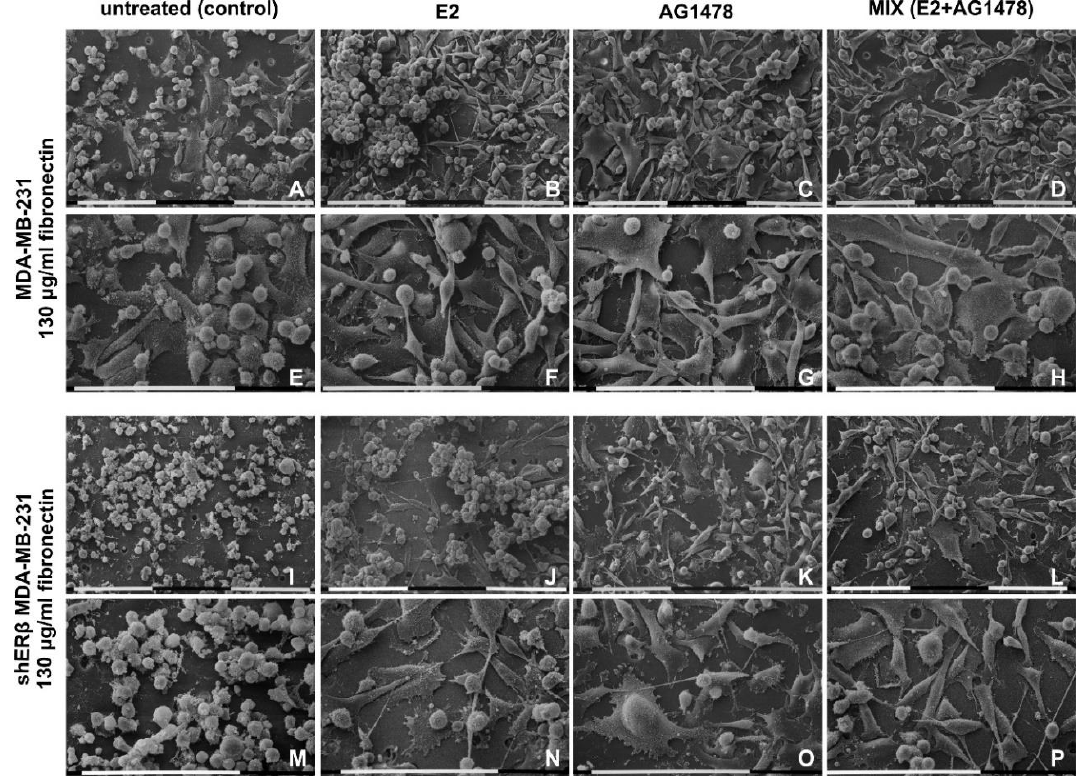
Figure 6. MDA-MB-231 and shERβ MDA-MB-231 cells cultured on Millipore filter covered by 130 µg/mL FN. ( A , E ) Untreated MDA-MB-231 cells displayed three different cell phenotypes: more numerous globular cells, large flattened-polygonal cells and fewer elongated-fusiform ones. Very few short filopodia and only few intercellular TNTs are observable. ( B , F ) With E2 treatment, MDA-MB-231 cells show isolated or grouped globular cells usually growing in more than one layer on more numerous elongated-fusiform and flattened-polygonal ones. Long conical filopodia and intercellular TNTs are visible. ( C , G ) After treatment with AG1478, MDA-MB-231 cells appear more grouped and include globular phenotypes growing on fewer elongated-fusiform and increased very large flattened-polygonal ones vs. control group. Few filopodia and TNTs are also visible. ( D , H ) With mix treatment, MDA-MB-231 cells appear grouped and show globular, large flattened-polygonal and elongated-fusiform shapes; long filopodia and TNTs. ( I , M ) Untreated shERβ MDA-MB-231 cells mainly show grouped globular cells but some isolated globular cells with few microvilli, and few EVs are also present. No filopodia are observable, whereas few short TNTs connect adjacent cells. ( J , N ) After E2 treatment, shERβ MDA-MB-231 cells display isolated and grouped globular cells growing in different layers on flattened-polygonal and isolated elongated-fusiform cells. Cells display microvilli and few EVs, long filopodia and TNTs. ( K , O ) After AG1478 treatment, the shER β MDA-MB-231 cells include many large flattened-polygonal, globular and elongated-fusiform cells which appeared a little more grouped when compared to the E2 group. Few microvilli and few EVs, long filopodia and TNTs are observable. ( L , P ) The same cells treated with both E2 and AG1478 (mix) comprise globular, flattened-polygonal and elongated-fusiform cells equally represented and exhibiting few EVs and few microvilli, long filopodia and TNTs. Bar = 0.1